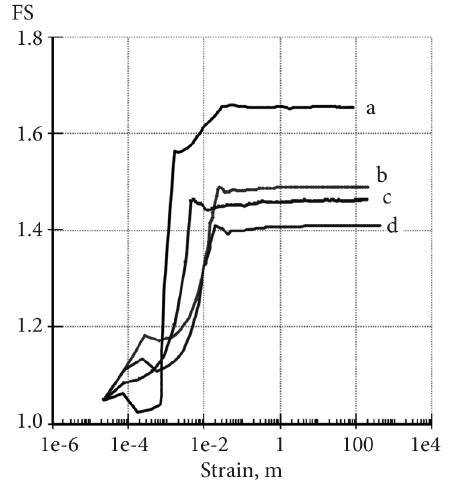
Figure 4. Slope stability factors in cases of reinforced and unreinforced with root of alder tree (a, cutslope reinforced; b, fillslope reinforced; c, cutslope unreinforced and d, fillslope unreinforced)